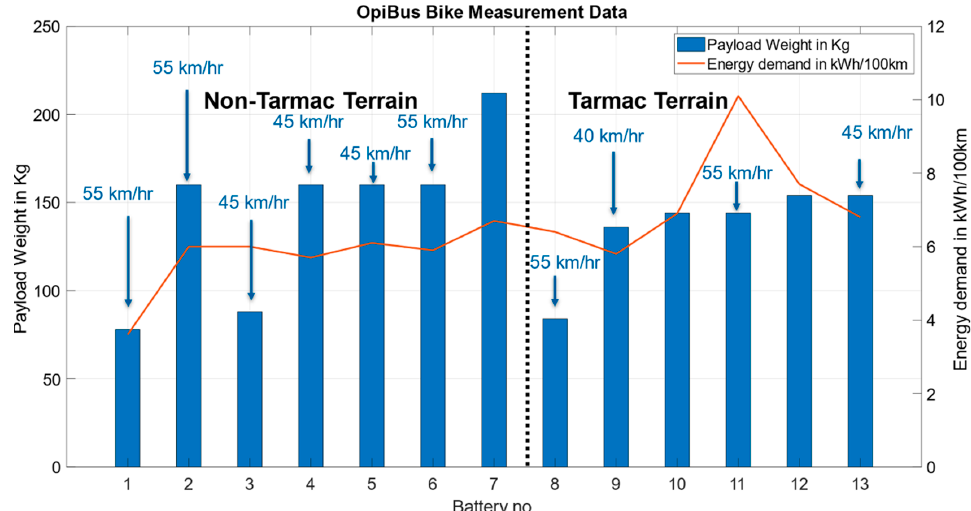
Figure 16 . Battery electricity demand depending on the road surface (OpiBus).